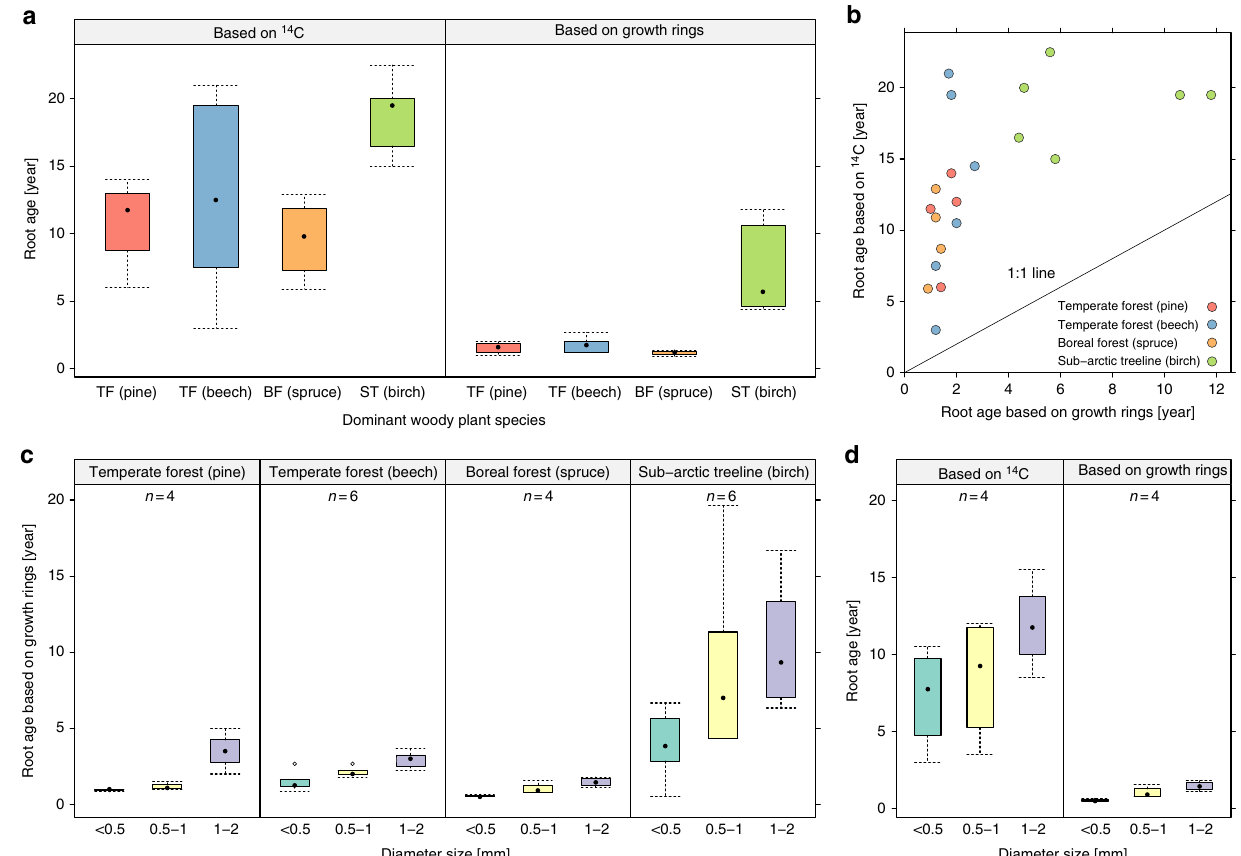
Fig. 3 Comparison of root ages based on annual growth rings and based on radiocarbon. a Comparison between the age of fi ne roots (mixture of all fi ne roots with a diameter size <2 mm) estimated by counting the number of annual growth rings in the secondary xylem and the radiocarbon ( 14 C)-based age of the same fi ne-root samples in different climate zones with different dominant woody species, and b deviation from the 1:1 line. c Comparison between the age of fi ne roots with different diameter sizes (<0.5, 0.5 – 1, 1 – 2 mm) estimated by counting the number of annual growth rings among forest ecosystems. d In the boreal forest dominated by spruce, radiocarbon was also measured in roots with different diameter sizes (<0.5, 0.5 – 1, 1 – 2 mm) and compared to the age of fi ne roots estimated by counting the number of annual growth rings of the same fi ne root samples. In the box-plots, the dot represents the median, the box denotes the interquartile range, the whiskers show 1.5 times the interquartile range of the data and points more than 1.5 times the interquartile range are plotted individually 51 . TF temperate forest, BF boreal forest, ST sub-arctic